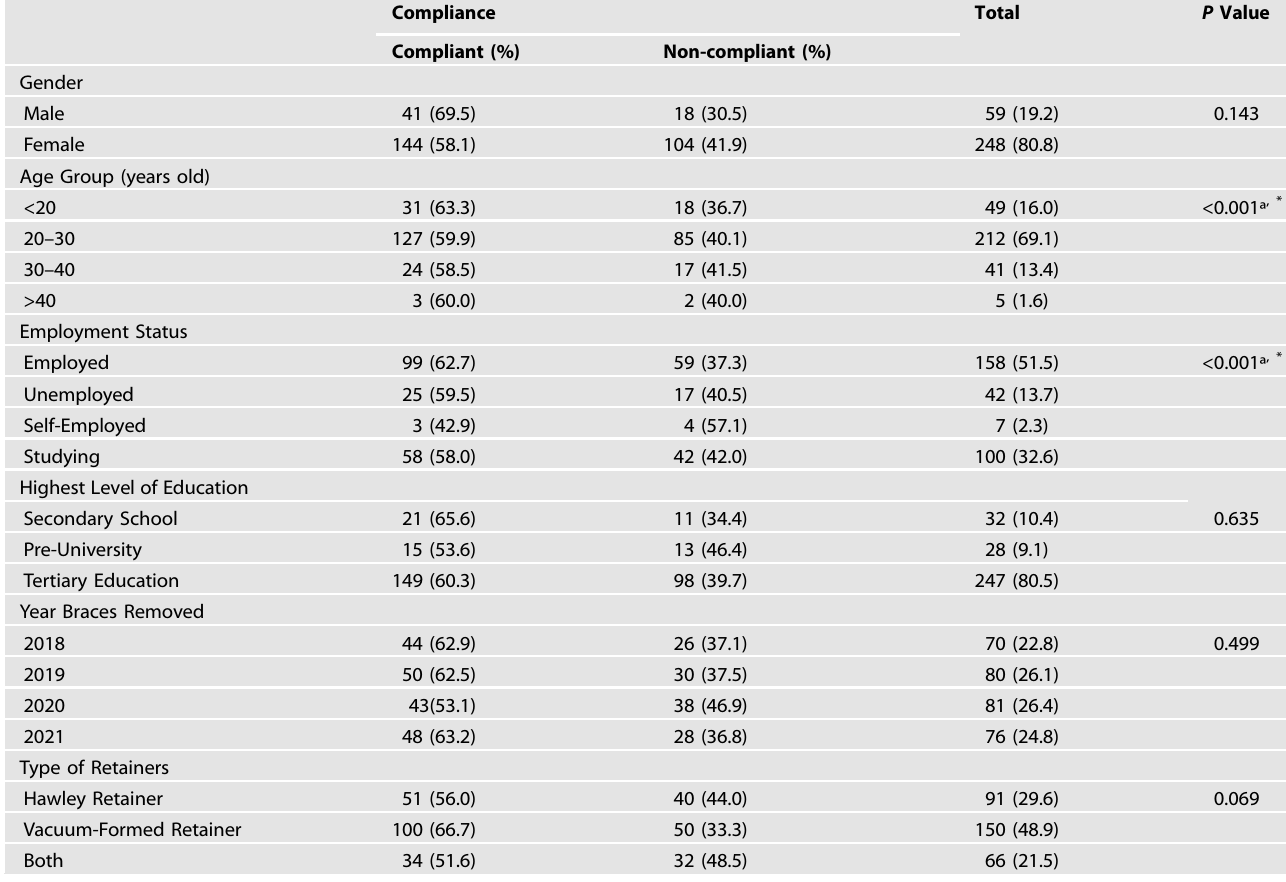
Table 1. Patient compliance to retainer wear according to demographic factors ( n =